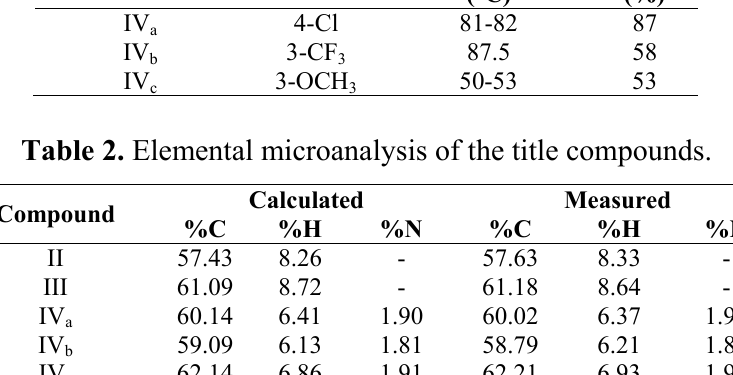
Table 1. Physical properties of the title compounds. Compound